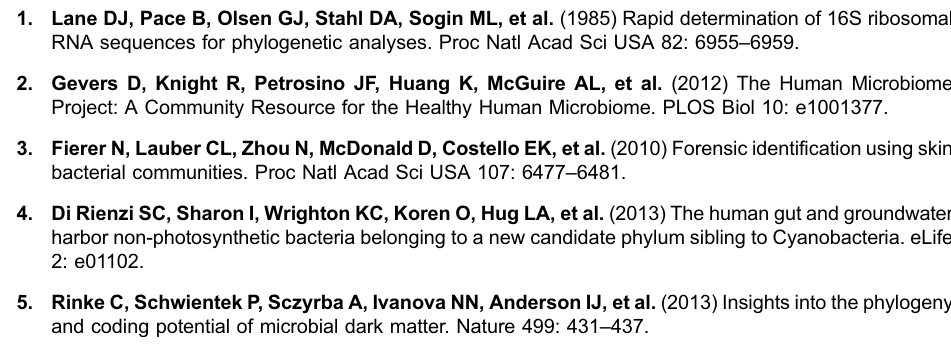
S2 Table. Comparison of OTU counts for synthetic mock communities. Comparison of OTU counts at 97% sequence identity, averaged for the 100 synthetic mock communities used for validation. From the table we can observe the trend of Full length reads showing comparable or higher OTU counts than the short read types, and among these short reads, R1 shows the higher OTU counts. S1 Text. Supplemental Information for ‘‘IM-TORNADO: A Tool for Comparison of 16S Reads from Paired-End